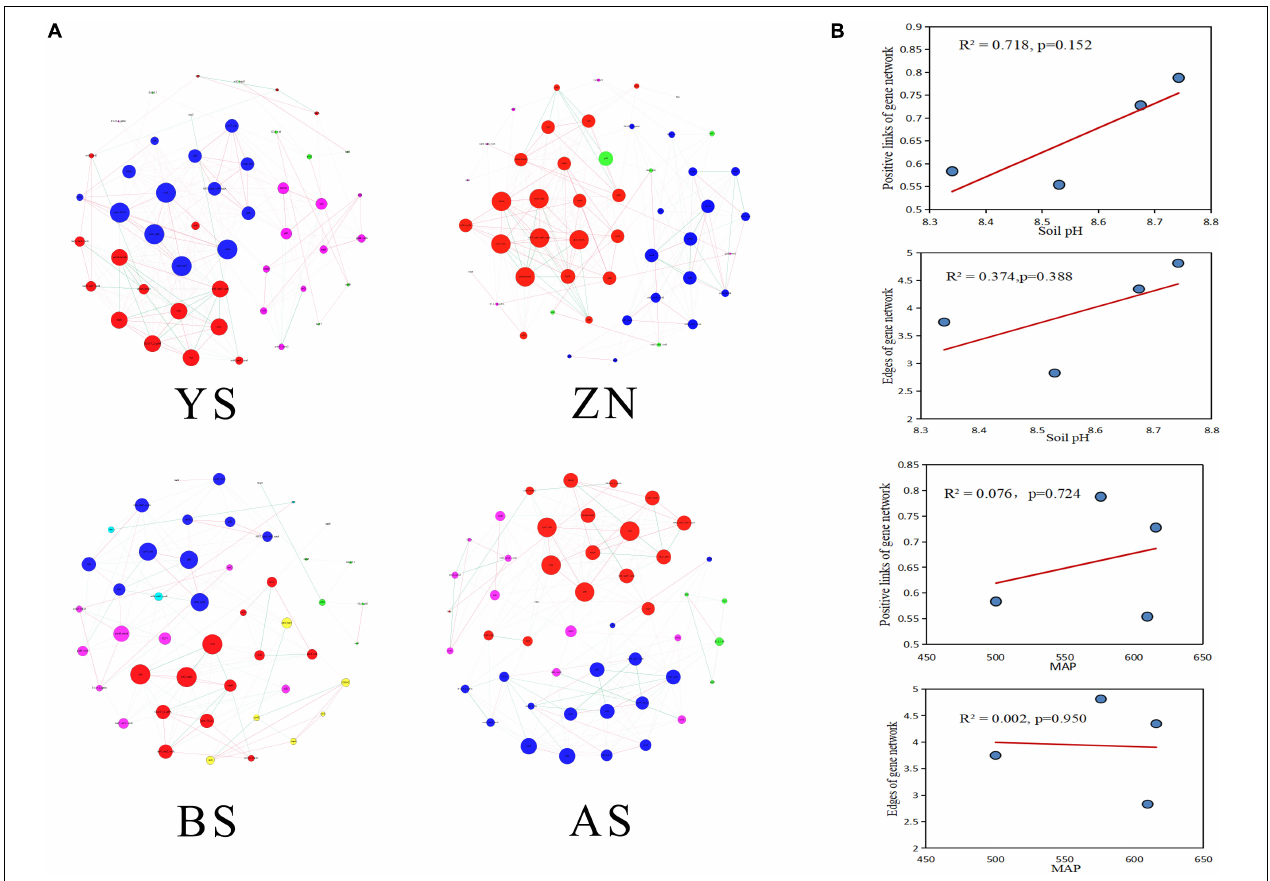
FIGURE 3 | Occurrence networks of genes involved in N-metabolism in rhizosphere soils in four counties. (A) The nodes with different colors in the networks represent the dominant modules. (B) Scatter plots with a regression curve was used to identify the distribution of the percentage of positive links and the number of edges in the co-occurrence networks of the four counties with the changes of MAP and soil